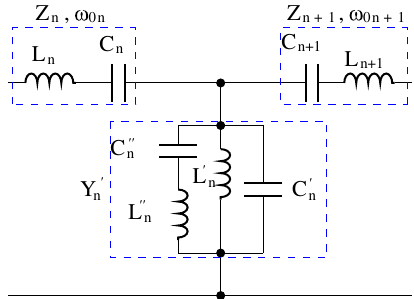
FIG. 2. The schematic representation of three adjacent cells in terms of equivalent impedance and